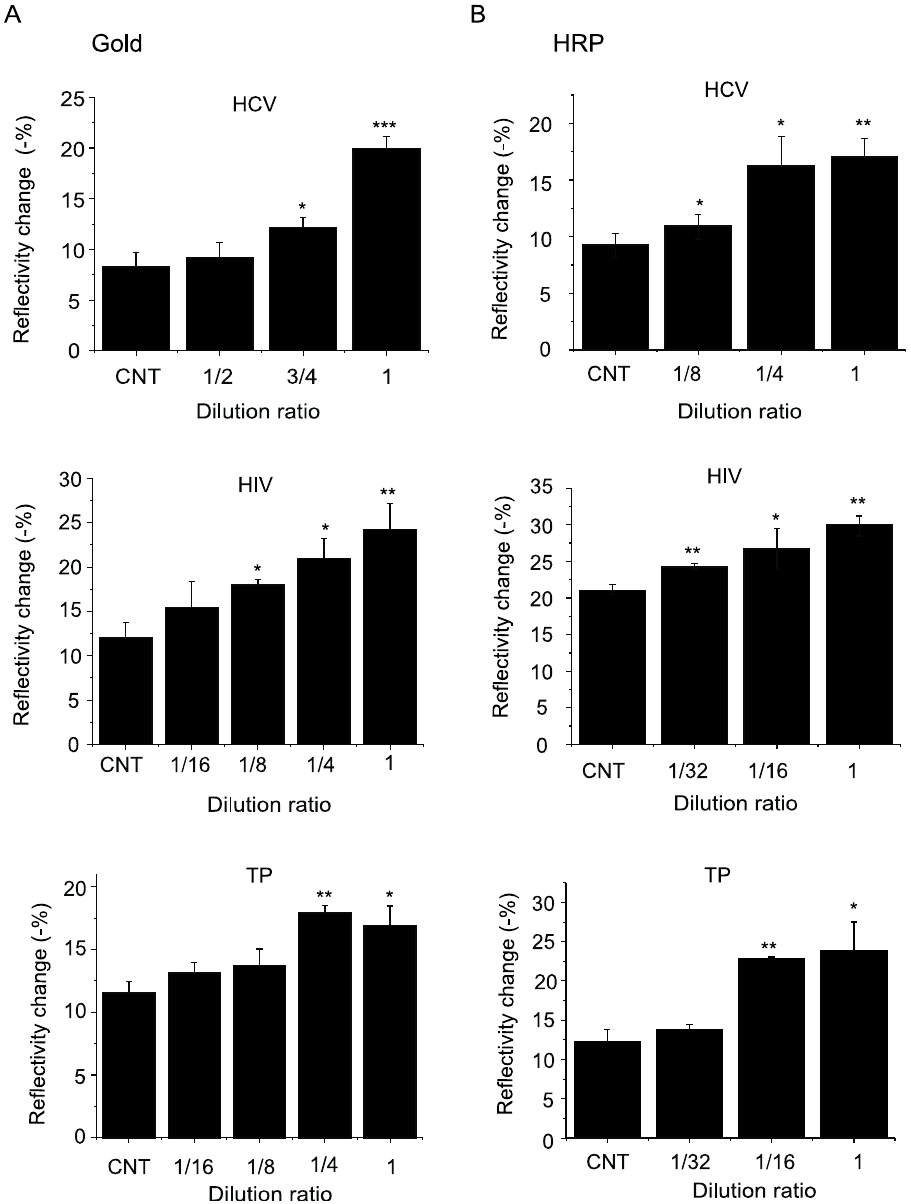
Figure 4. Comparison of detection sensitivity of signal enhancement using gold nanoparticles ( A ) and a peroxidase reaction ( B ). Changes in a dip of a spectrum were measured at the time point of 300 seconds (5 minutes) as shown in Figure 2. CNT, control plasma. Plasma positive for antibody against HCV, HIV or TP were diluted in indicated ratios. * p < 0.05, ** p < 0.01, *** p < 0.001 versus control plasma (n = 3 for each